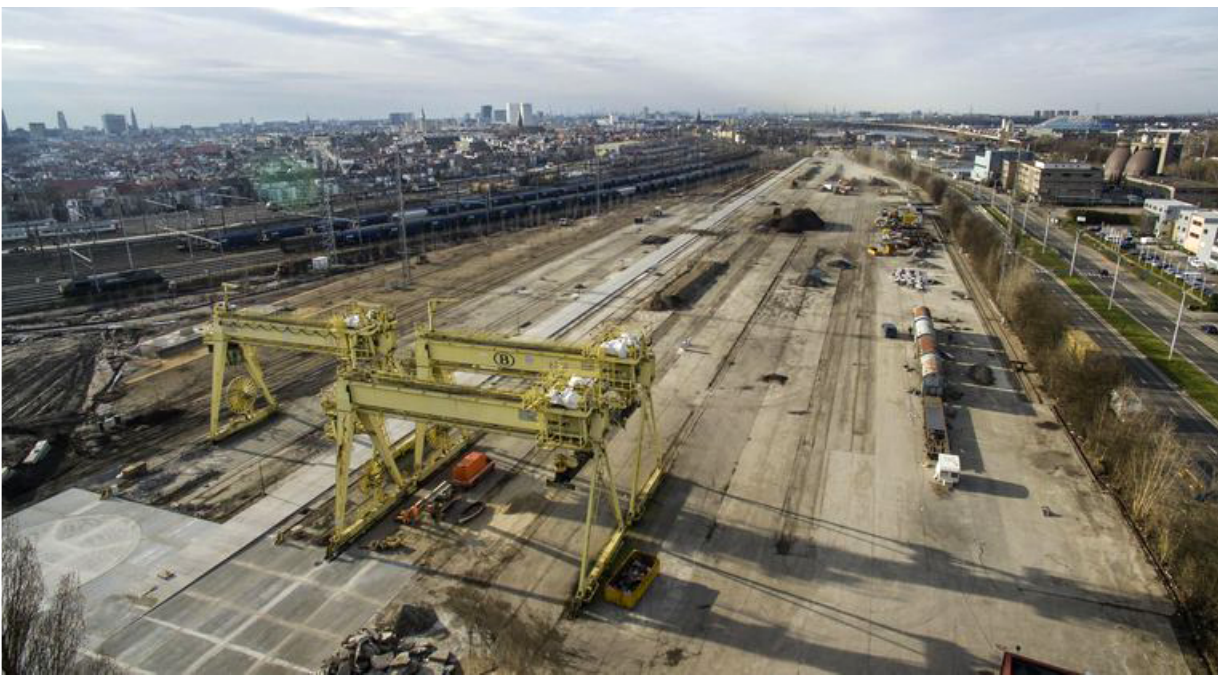
Figure 3. The PSO: An abandoned railway yard in the north of Antwerp. The collective learning trajectory of PSO was a rather fluctuating process. As an action group PSO highly de- pended on changing contextual conditions such as the existence of an official vision on the PSO, legal proce- dures etc. A first reorganization of the group and its learn- ing trajectory was carried out after difficult negotiations with the City on the future of the abandoned railway